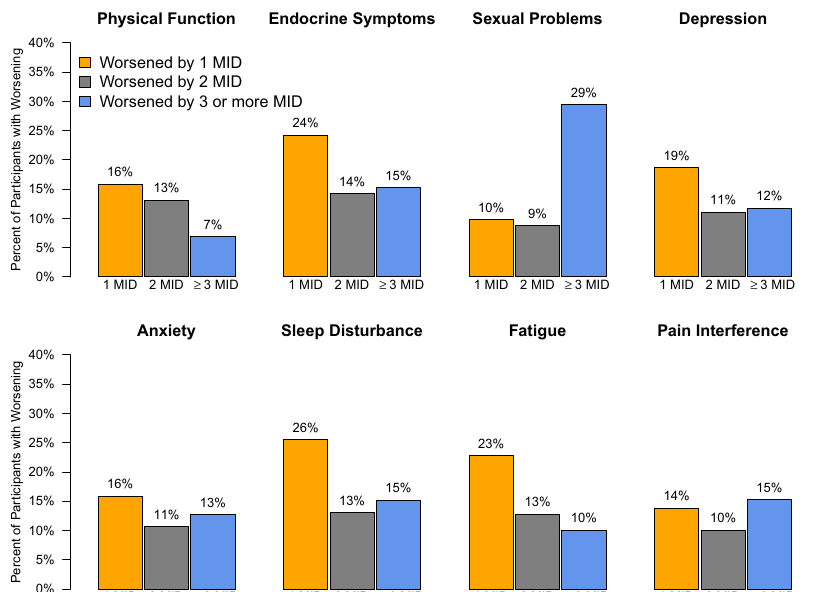
Fig. 2 Proportion of participants who experienced worsening of patient-reported outcome scores exceeding the minimal important difference at any time point through 60 months. Bar plots display worst change in PRO scores at any time point in follow-up through 60 months. Worst changes are categorized as at least the MID but less than twice the MID, at least twice the MID but less than three times the MID and at least three times the MID for each measure. Only participants with baseline values and at least one follow-up measure are included. The proportions of participants whose worst changes in each PRO scores were less than the MID (i.e. who experienced improvement, no change or worsening less than the MID) are not displayed. The MID was considered to be 4 points for the physical function, depression, anxiety, sleep disturbance, fatigue, and pain interference measures; 8 points for the sexual problems measure; and 5 points for the endocrine symptoms measure. MID minimal important difference, 1 MID at least the MID but less than twice the MID, 2 MID twice the MID but less than three times the MID, 3 MID at least three times the MID, PRO patient-reported